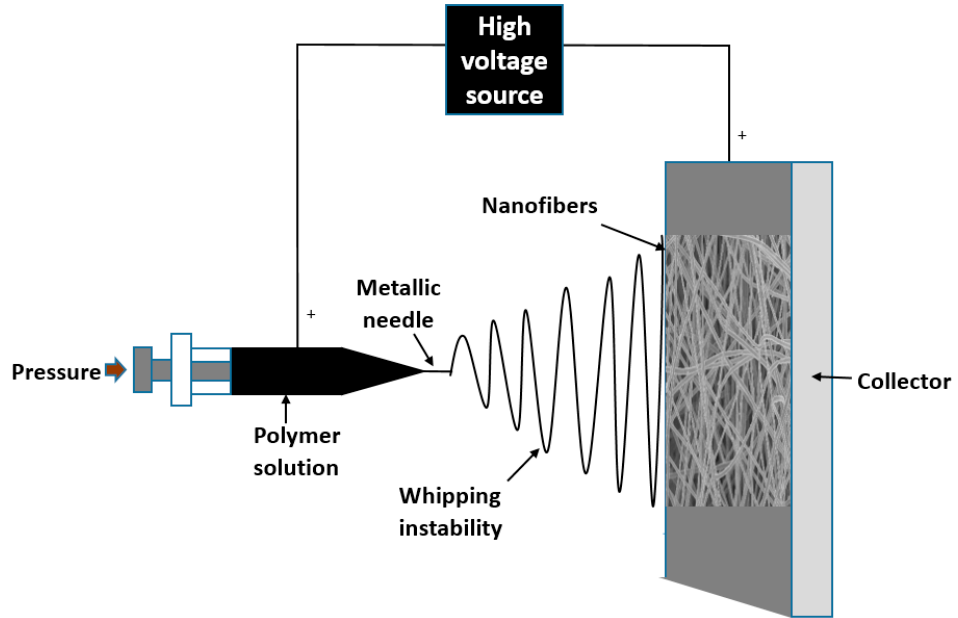
Figure 2. Schematic showing the features of the electrospinning setup for fabricating the membrane material in the present study.